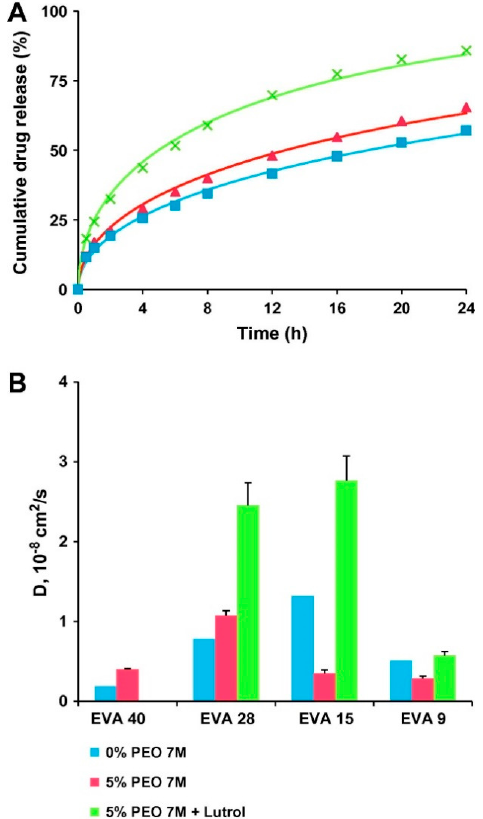
Figure 4. ( A ) Theory (curves) and experiments (symbols): metoprolol tartrate release from EVA 28-based matrices containing 0% PEO 7 M ( ), 5% PEO 7 M ( ), or 5% PEG 7 M/Lutrol (9/1, w / w ) (×). ( B ) Apparent diffusion coefficients of metoprolol tartrate in EVA-based matrices, containing 0% PEO 7 M, 5% PEO 7 M, or 5% PEO 7 M/Lutrol (9/1, w / w ). Adapted from [68], Elsevier, 2012 with permission.